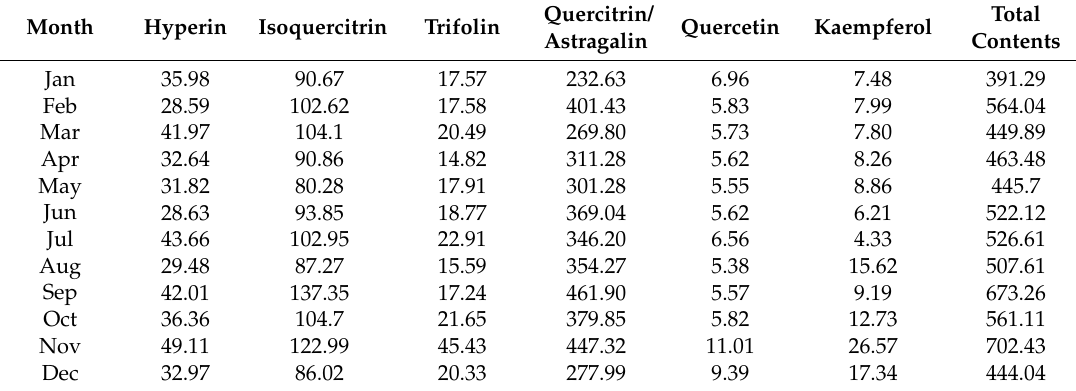
Figure 1. High performance liquid chromatography profile of tea extract from Nov at 350 nm. Table 2. Contents of hyperin, isoquercitrin, quercitrin and astragalin, quercetin and kaempferol of different samples (in μ g/g)